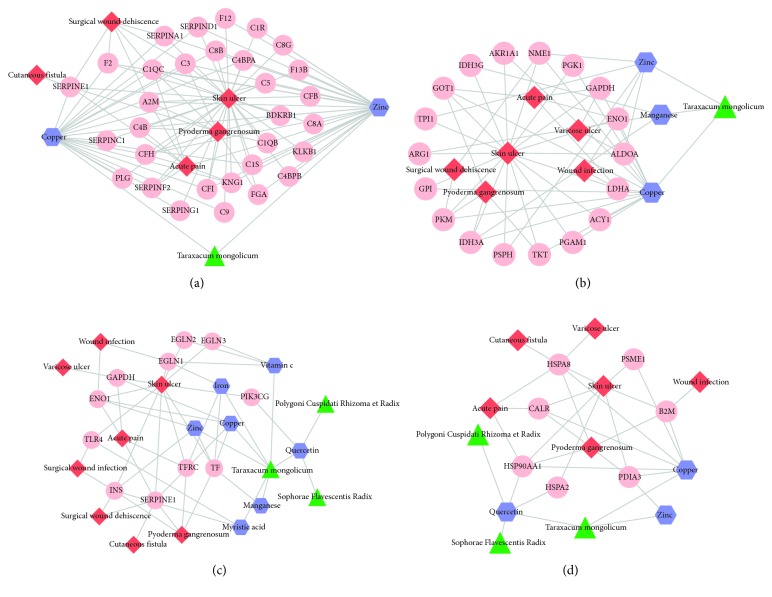
Subnetwork analysis.